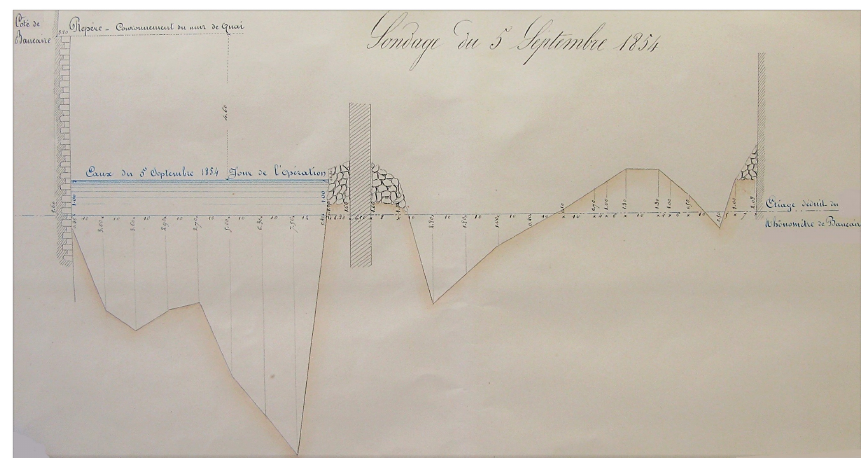
Figure 6. Cross section at the suspension bridge of Beaucaire-Tarascon. The low-flow water level deduced from the Beaucaire gauging station and the water level on the day of the survey (5 September 1854) are indicated in blue (source: Aymard, AD Rhône, S